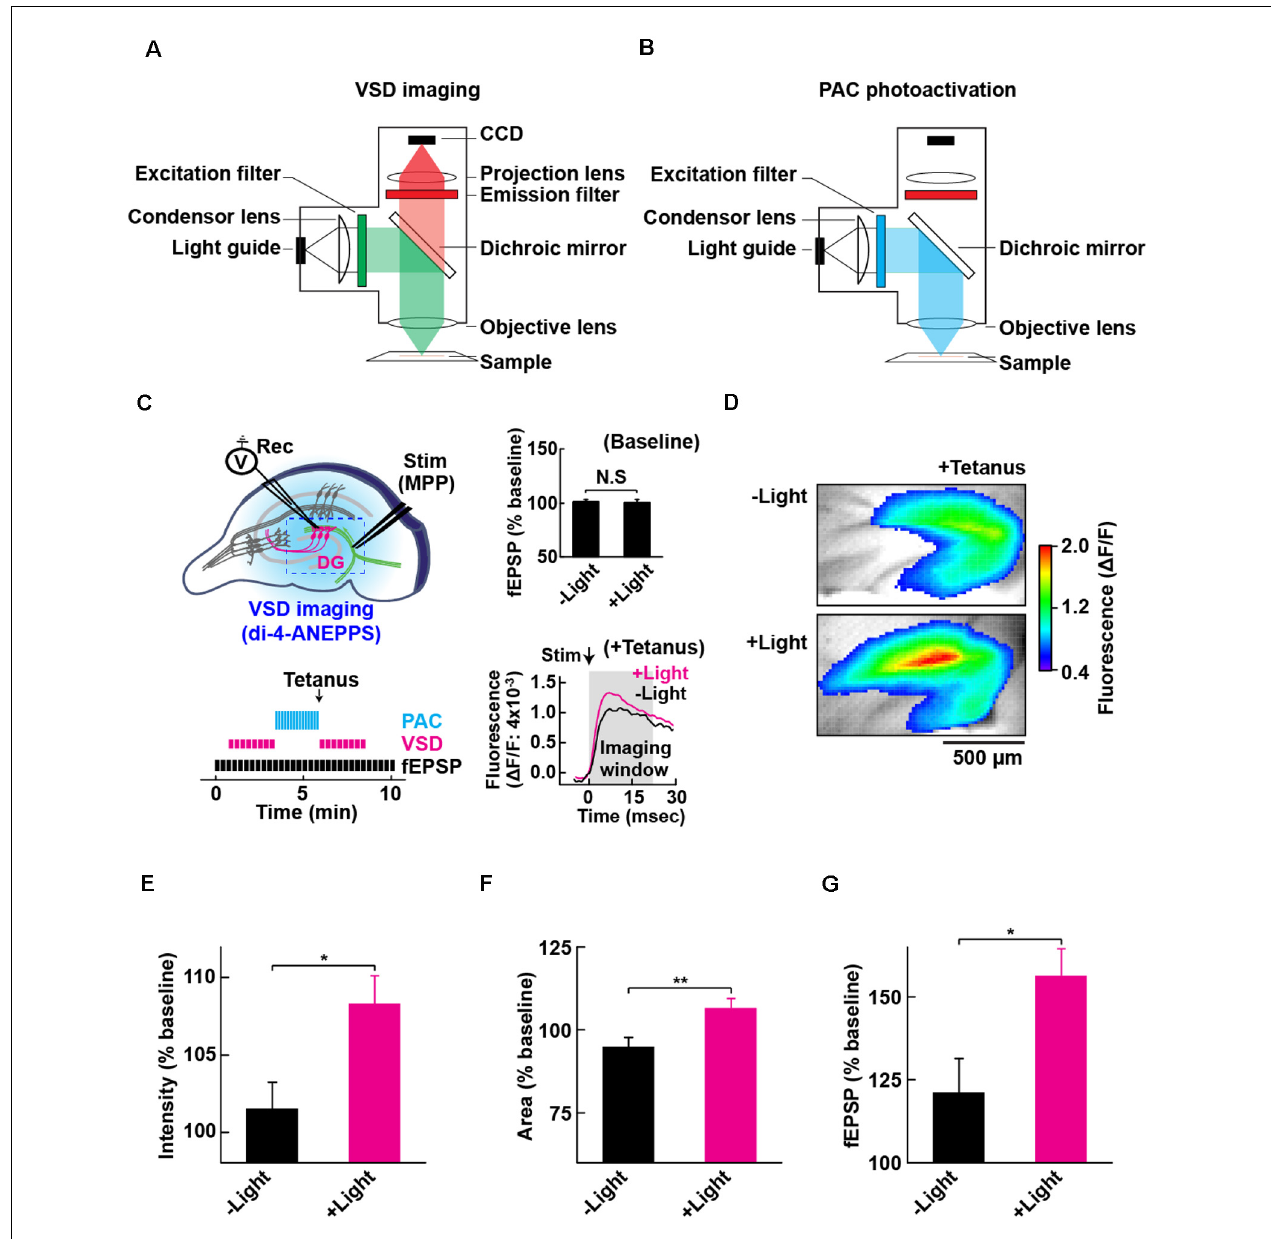
FIGURE 4 | Configuration for PAC photoactivation and voltage-sensitive dye (VSD) imaging. A schematic of the setup for VSD imaging (A) and PAC photoactivation (B) in the fluorescence microscope. After PAC photoactivation, we switched the filter cube to detect VSD optical signal by the CCD-based camera system. The excitation light (530 ± 10 nm) for VSD imaging does not photoactivate PAC (down to 500 nm). (C) Left upper: schematic of PAC photoactivation, fEPSP recording and VSD imaging in PAC Tg hippocampal slices. The dotted rectangle indicates an ROI region for VSD imaging of fluorescence signal (di-4-ANEPPS). Left lower: time-course of VSD imaging with fEPSP recording before and after photoactivation of PAC with tetanic stimulation. VSD fluorescence changes were recorded as an average of eight images (400 ms duration each) taken every 20 s before and after tetanic stimulation (1 train, 100 × 100 Hz, 0.05 ms duration pulses). Right upper: quantification of synaptic response before/after PAC photoactivation for 60 s during the recording of VSD imaging ( n = 11 slices/3 mice. NS, p > 0.05 (paired t -test). Data are presented as mean ± SEM. Right lower: trace of VSD fluorescence signal with/without PAC photoactivation (+Light/ − Light). The black arrow (Stim) shows the time of delivery of tetanic stimulation which evoked the optical signals (at 0 ms). Gray box (Imaging analysis window): time window (0–20 ms) used for the measurement of fluorescence changes during basal stimulation and after the tetanic stimulation. (D) Representative VSD images in the DG area after tetanus with (+Light) or without ( − Light) PAC photoactivation. The VSD fluorescence signal changes are displayed in pseudo color at the peak change time (6.4 ms). Warmer red colors indicate higher fluorescence intensities, signifying stronger depolarization. (E–G) Quantification of the changes (C,D) in the averaged peak fluorescence intensity (E) and area (F) during 0.4–160 s after tetanus (8 × 20 ms imaging every 20 s), and the fEPSP changes 0.05 ms after tetanus (G) with (+Light, n = 8 slices/2 mice) or without ( − Light, n = 7 slices/2 mice) PAC photoactivation. * p < 0.05; ** p < 0.01 (unpaired t -test). Data are presented as mean ± SEM.